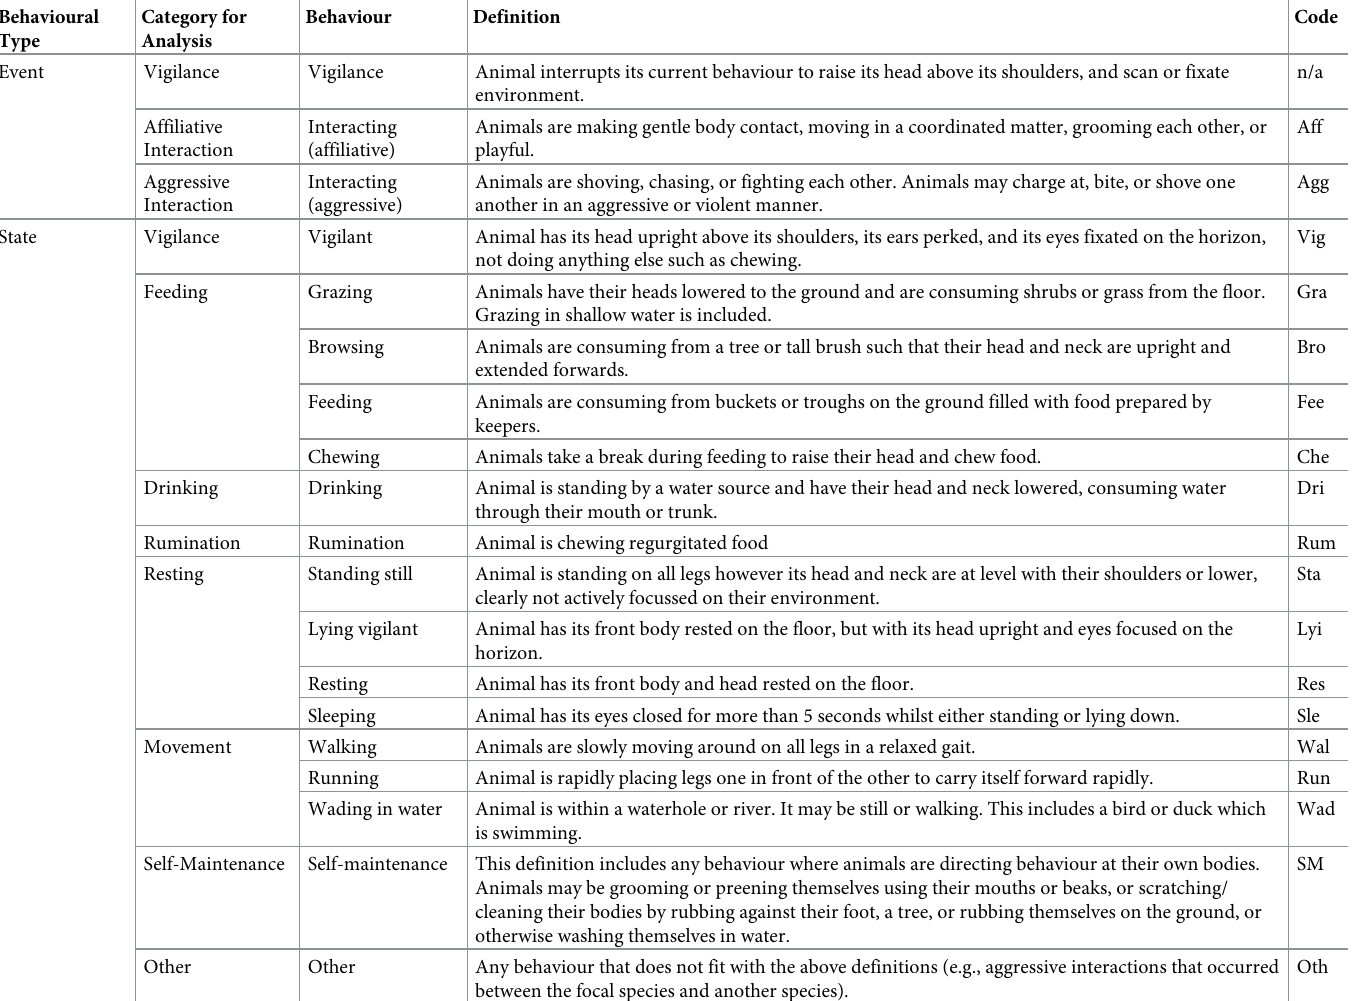
Table 2. Ethogram displaying how behaviours were defined, coded, and grouped for